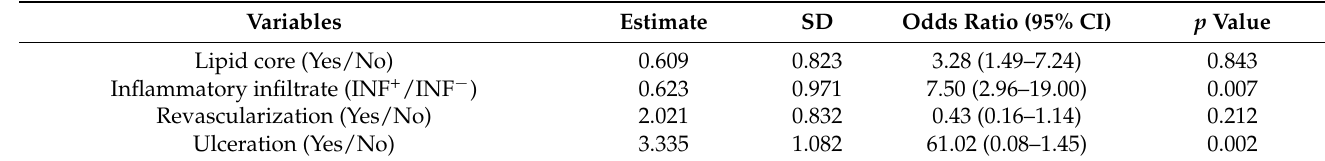
Table 6. Summary of multiple logistic regression analysis of the factors correlated to thrombotic complication in the overall patient group ( n = 119). Model 2